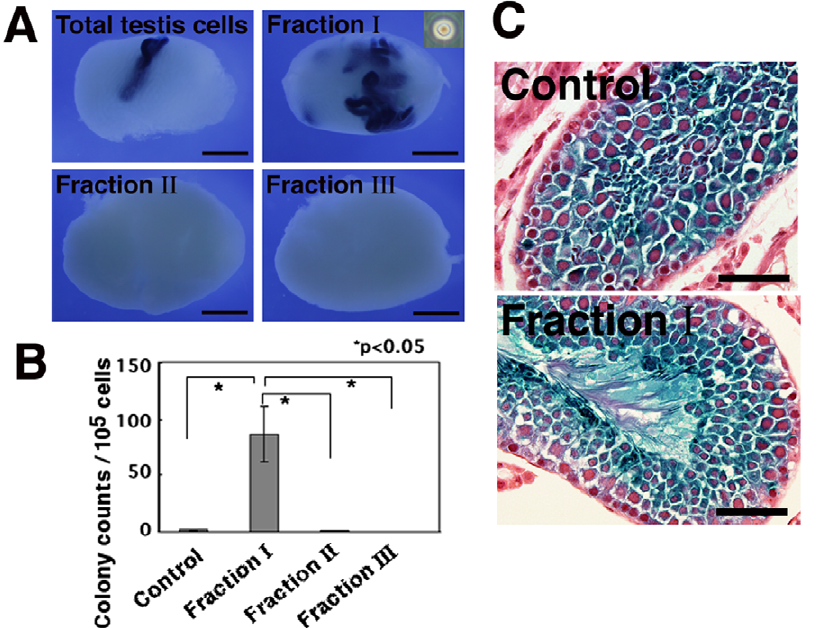
Figure 3. Functional analyses of SSC activity by germ cell transplantation of each CD9-selected cell fraction. (A) Macroscopic appearance of recipient testes. Approximately 4.9 6 10 3 , 2.3 6 10 4 , 3.5 6 10 2 , and 1.6 6 10 5 cells were transplanted for fractions I, II, III, and control cells, respectively. Recipient testes were stained with X-Gal 2 months after transplantation. Blue tubules indicate germ cell colonies developed from donor SSCs. Cells in fraction I have a uniform appearance (insert). (B) Quantification of colonies. The number of cells that could be recovered in each experiment varied, and thus the colony number was normalized to reflect donor cells at a concentration of 10 5 cells injected/testis. Cells in fraction I are significantly enriched for SSCs. (C) Histological sections of recipient testes. Note the normal appearance of spermatogenesis of donor-derived cells in recipients of control cells (Top) and fraction I cells (Bottom). Stain: X-Gal (A); X-Gal, Hematoxylin and eosin (C). Bars =1 mm (A), 50 m m (C).